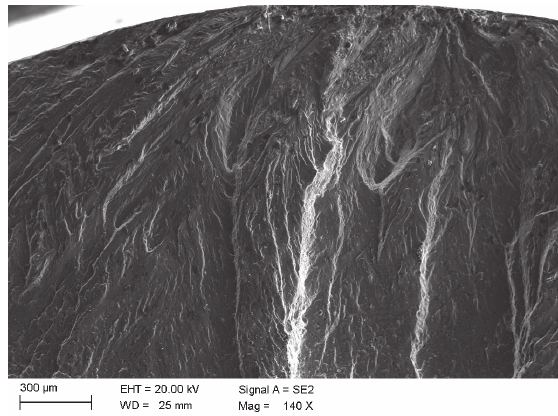
Figure 10: Temporary zone of a fracture, local cracking of the intercrystalline character of the AlZn6Mg0.8Zr